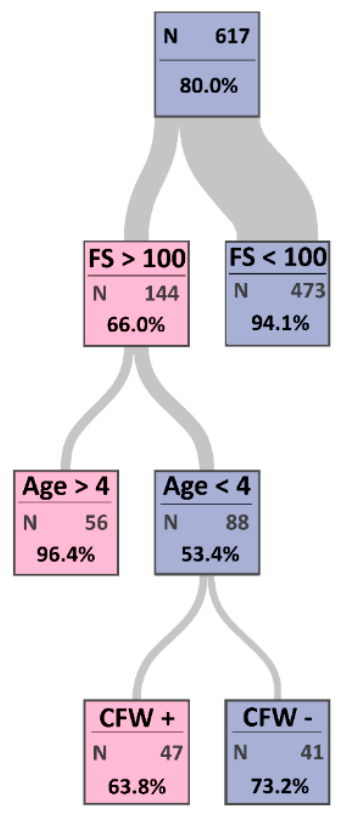
Figure 3. Estimated classification tree determining the most important risk factors of contagious caprine pleuropneumonia (CCPP) in sheep and goats. This tree started with node 0 representing all observations. The color of the square in each leaf node indicates the most frequent level of CCPP among the observations in that node, and this is also the classification level assigned to all observations in that node. The color of the node indicates seronegativity (purple) and seropositivity (pink) for CCPP. Each node has a proportion of observations that have the most frequent level in that node. The width of the link between parent and child nodes is proportional to the number of observations in the child node. The classification tree analysis indicated that flock size (FS), age, and communal food and water (CFW) are the most important risk factors of CCPP.